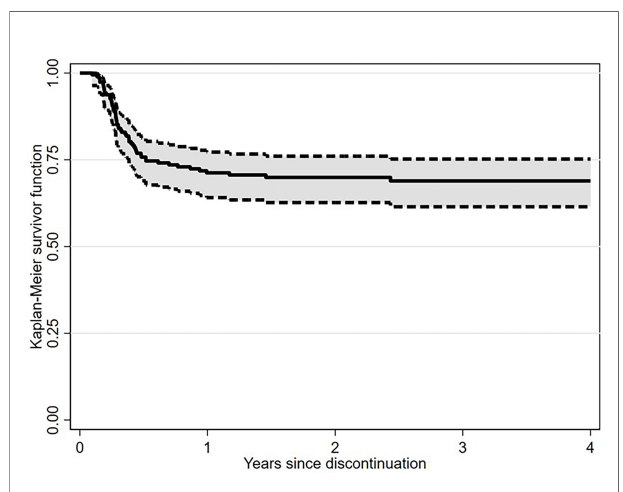
FIGURE 1 | Treatment-free remission (TFR) after tyrosine kinase inhibitor (TKI) therapy (Kaplan-Meier